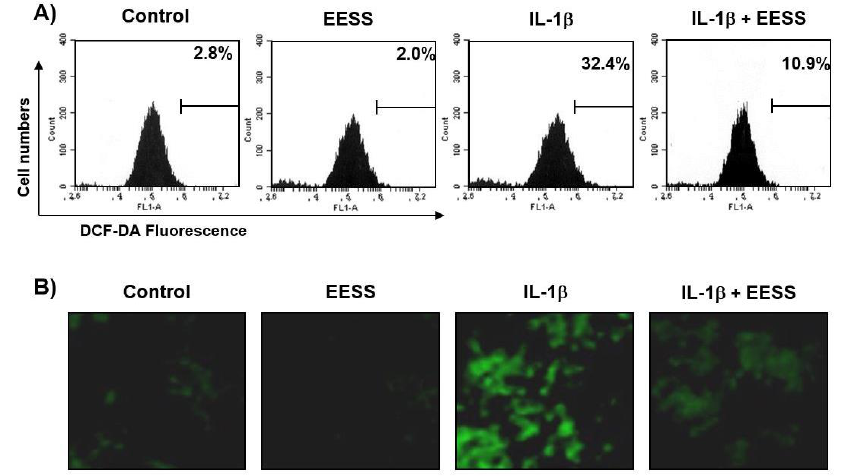
Figure 3. Effects of EESS on IL-1β-induced ROS generation in rat articular chondrocytes. Cells were pretreated with 300 μg/mL EESS for 1 h, and then stimulated with or without 40 ng/mL IL-1β for 1 h. Cells were incubated with 10 µ M DCF-DA for 30 min at 37 ◦ C. ( A ) The cells were collected, and DCF fluorescence was measured by flow cytometry. Values represent the means of two independent experiments. ( B ) Images were obtained by fluorescence microscopy, and those presented are from one experiment, and are representative of at least three independent